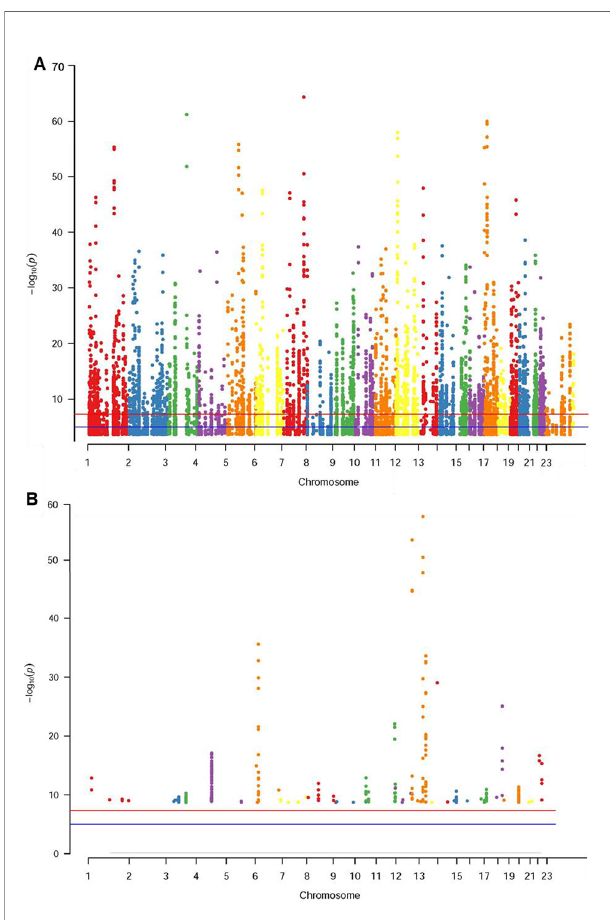
FIGURE 1 | Manhattan plot of genome ‐ wide identi fi ed m 6 A-eQTLs in sepsis patients. The Manhattan plot displayed − log10 (p values) for each of m 6 A- eQTLs associated with sepsis. (A) m 6 A-cis-eQTLs (B) m 6